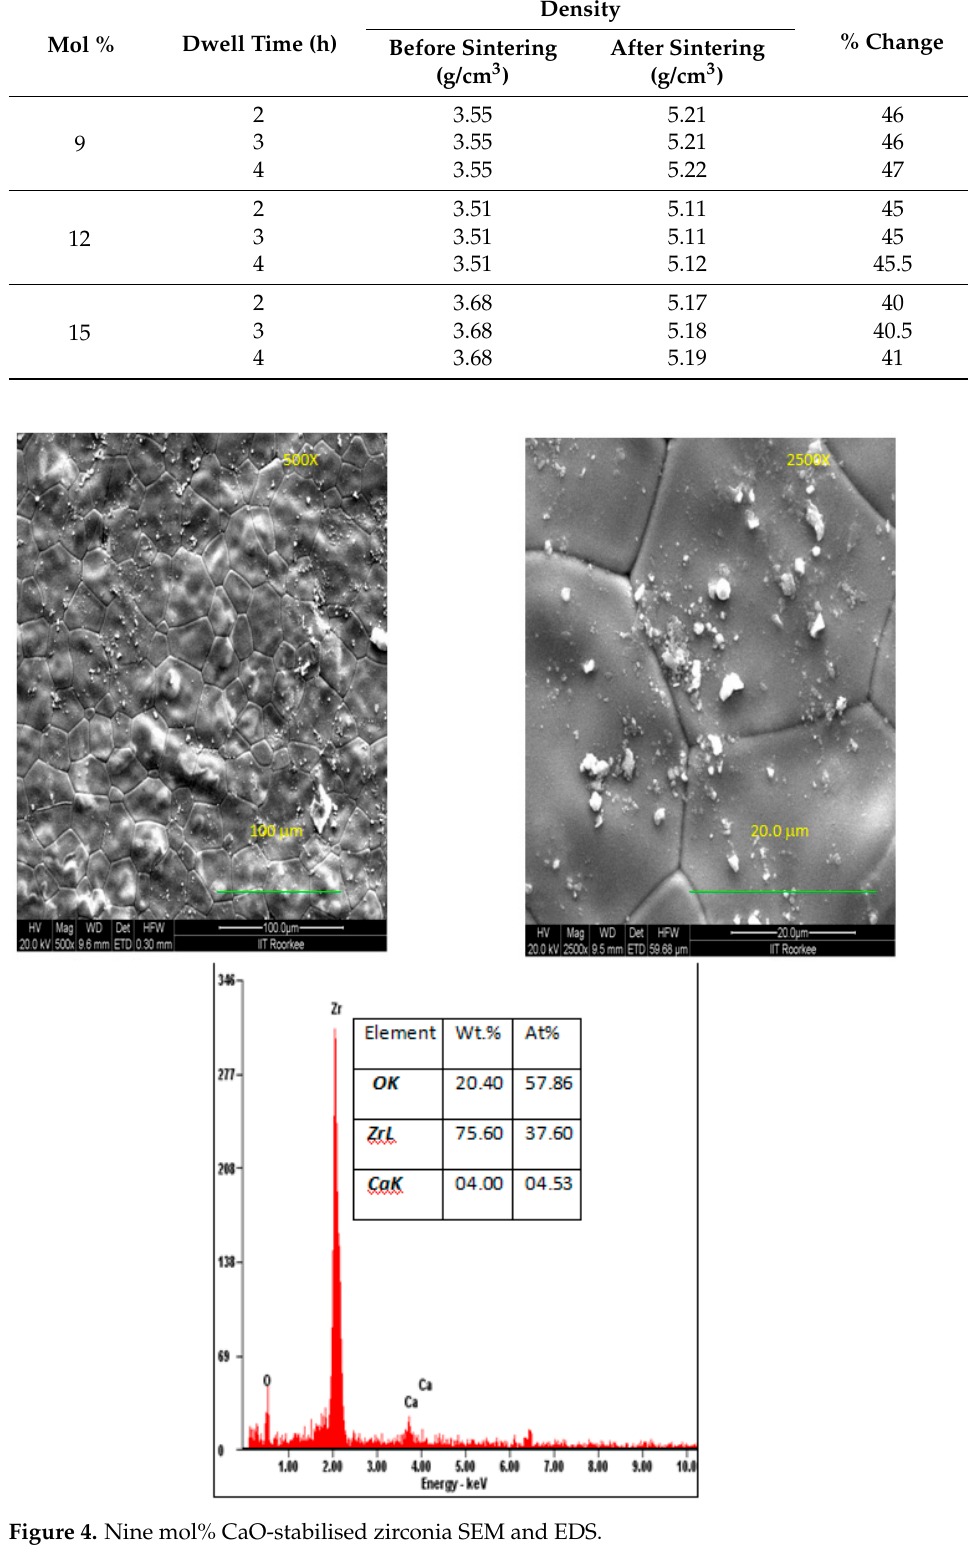
Table 4. Density measurements of Group B CSZ samples at sintering temperature of 1500 °C.